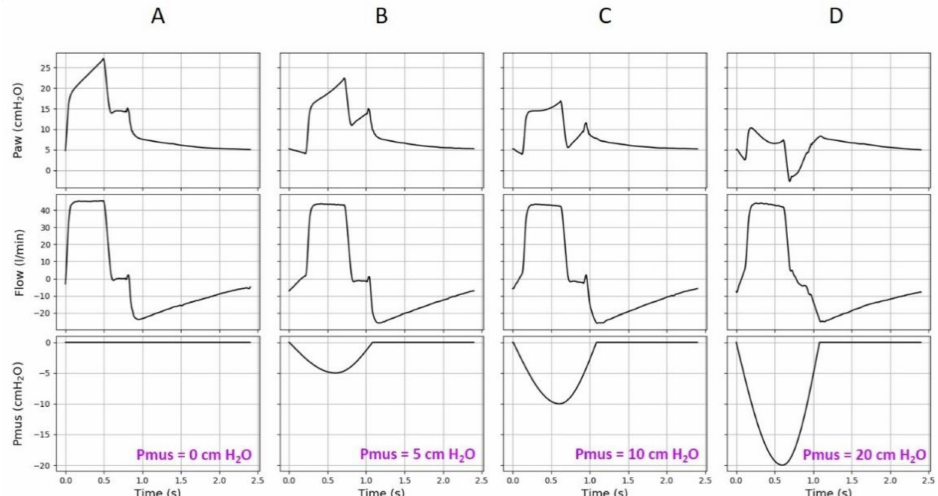
Figure 3. Effect of inspiratory effort on the airway pressure waveform during volume assist-control ventilation. A ventilator set in volume assist-control ventilation was connected to an active lung simulator. Passive conditions were simulated ( A ), followed by increasing inspiratory effort with a simulated muscle pressure of 5 ( B ), 10 ( C ), and 20 ( D ) cm H 2 O. As inspiratory effort increased, the airway pressure decreased and the waveform became “deeper”. This phenomenon makes it possible to detect intense inspiratory efforts by analyzing the ventilator’s waveforms at the bedside. Note that a Pmus of 5, 10 and 20 cm H 2 O correspond to an esophageal pressure swings ( ∆ Pes) around 3, 8 and 18 cm H 2 O. Definition of abbreviations: Paw: airway pressure; Flow: airway flow; Pmus: muscle pressure of the inspiratory